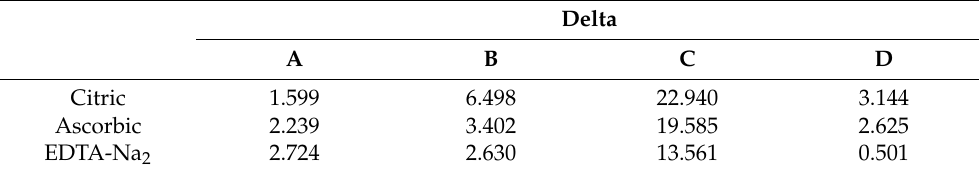
Figure 3. S / N ratio plots for the effects of experimental parameters for EDTA-Na 2 . Table 2. Delta values from Taguchi